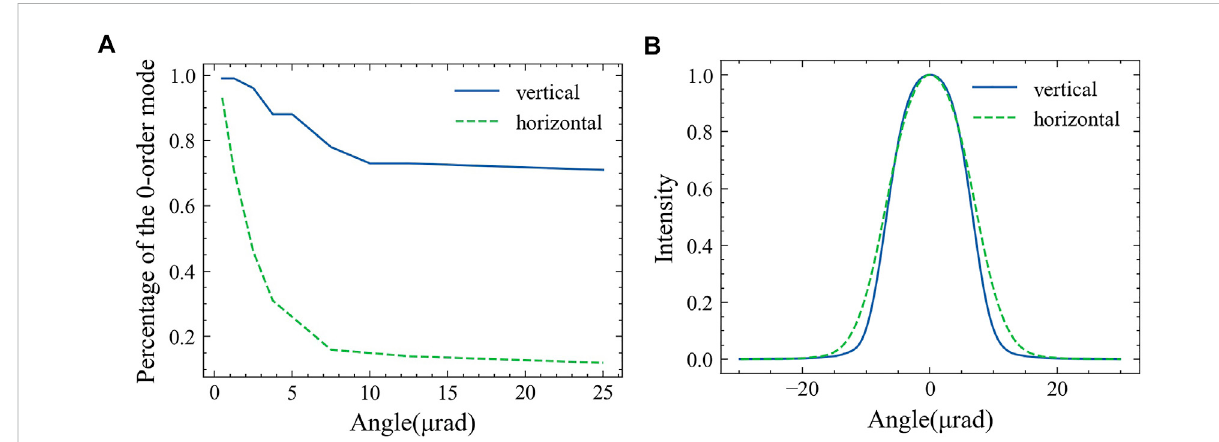
FIGURE 10 Coherence (A) and intensity (B) distribution of light fi eld by the undulator source. Coherence is measured by the percentage of the 0-order